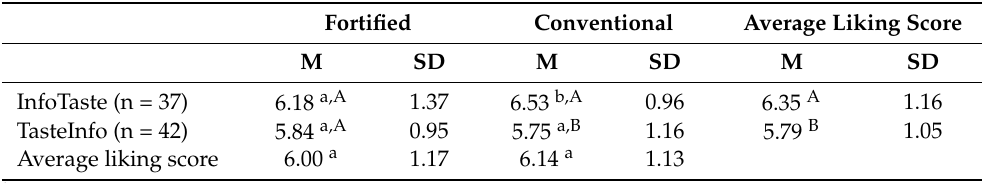
Table 3. Overall liking of fortified and conventional fish according to the rate of acquired information before sensory evaluation 1 .